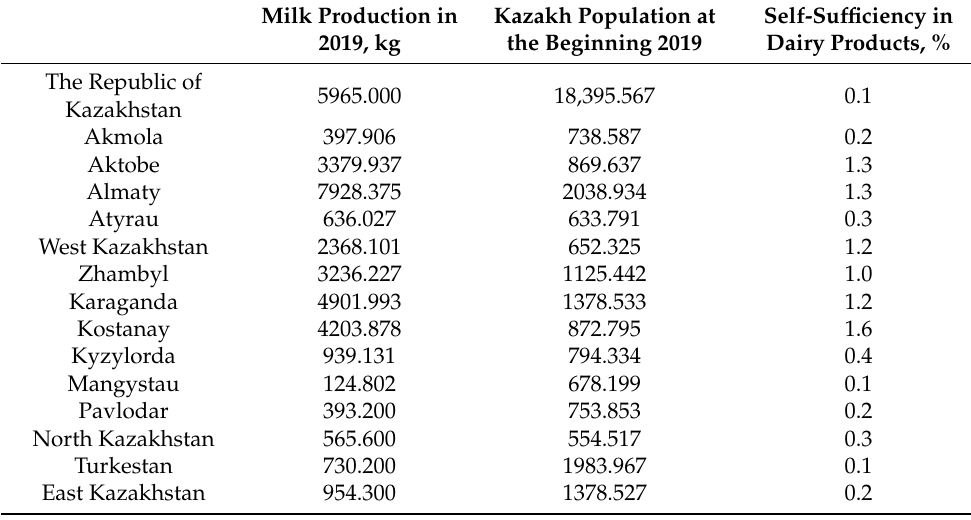
Table 3. Average self-sufficiency of the Republic of Kazakhstan in dairy products (2019) (source: Stat.gov.kz, 2021. Available online: https://stat.gov.kz/ (accessed on 26 May 2021). Milk Production in 2019, kg Kazakh Population at the Beginning 2019 Self-Sufficiency in Dairy Products, %